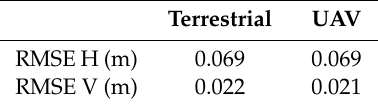
Table 4. RMSE of Chedi, computed on 20 checkpoints for the terrestrial and UAV point